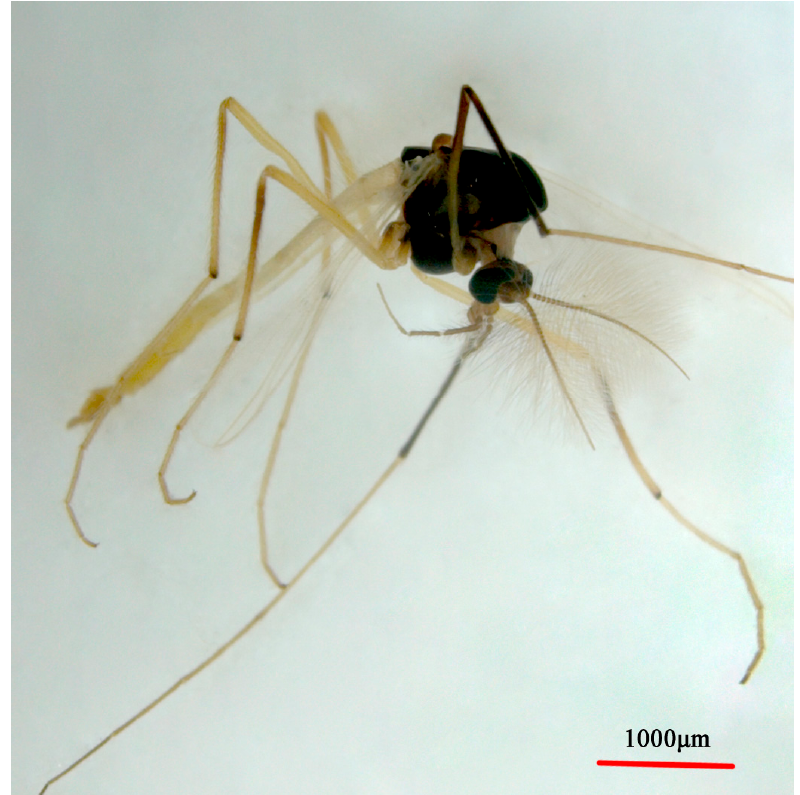
Figure 8. Male adult (holotype, in lateral view) of Microtendipes nigrithorax sp. nov.